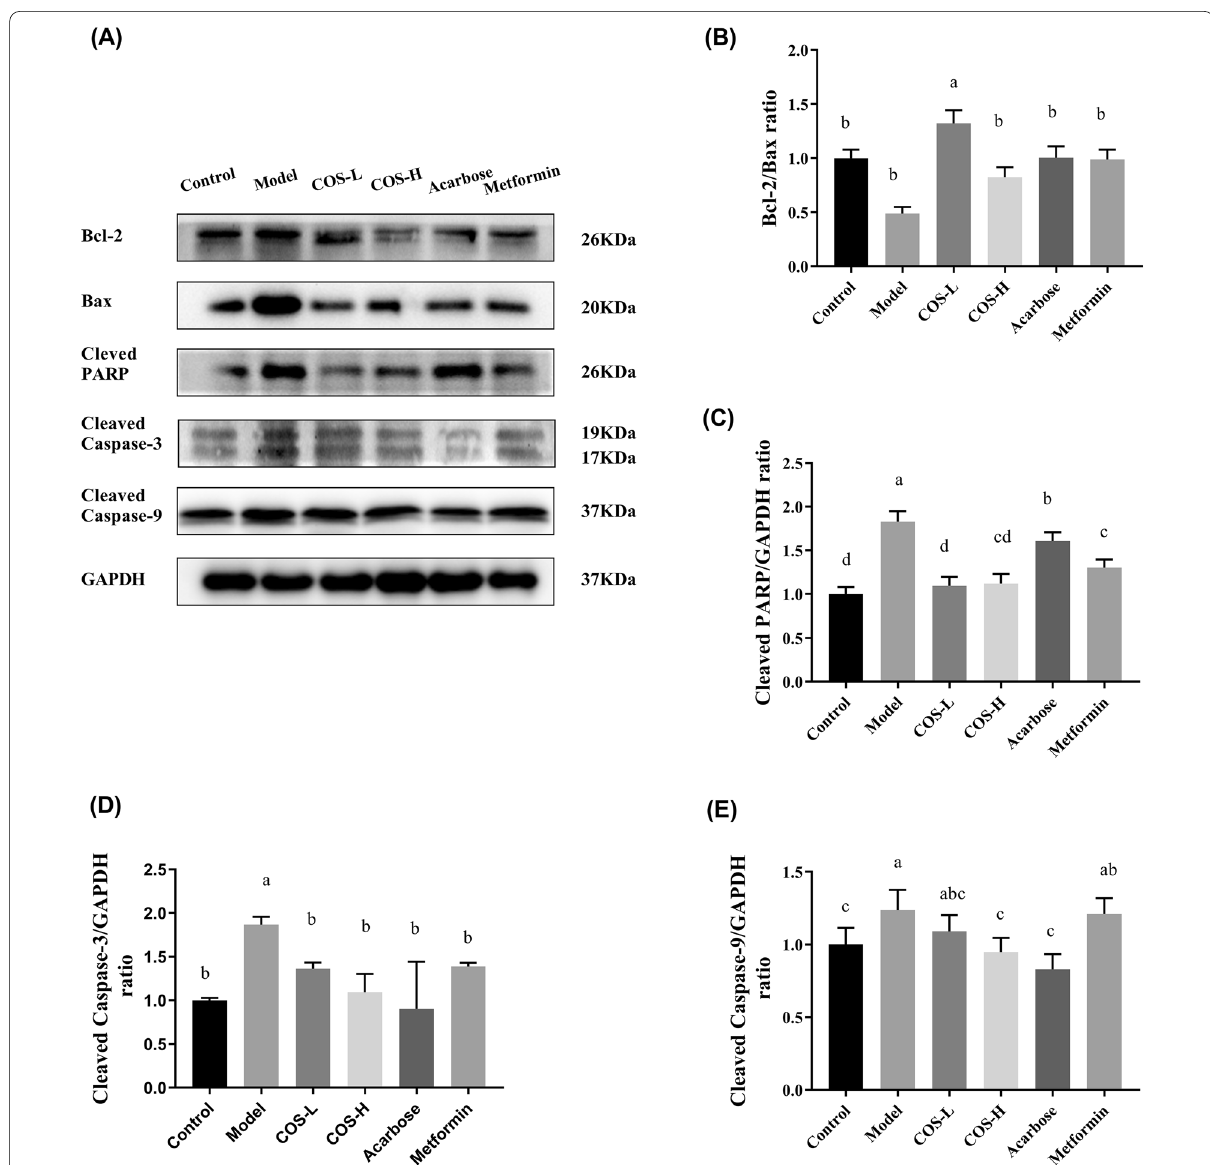
Fig. 8 The apoptotic protein expression in the mouse pancreas. A Western blot images, B Bcl2/Bax, C cleaved PARP/GAPDH, D cleaved caspase-3/ GAPDH, E cleaved caspase-9/GAPDH. Normalization versus GAPDH ensured equal protein